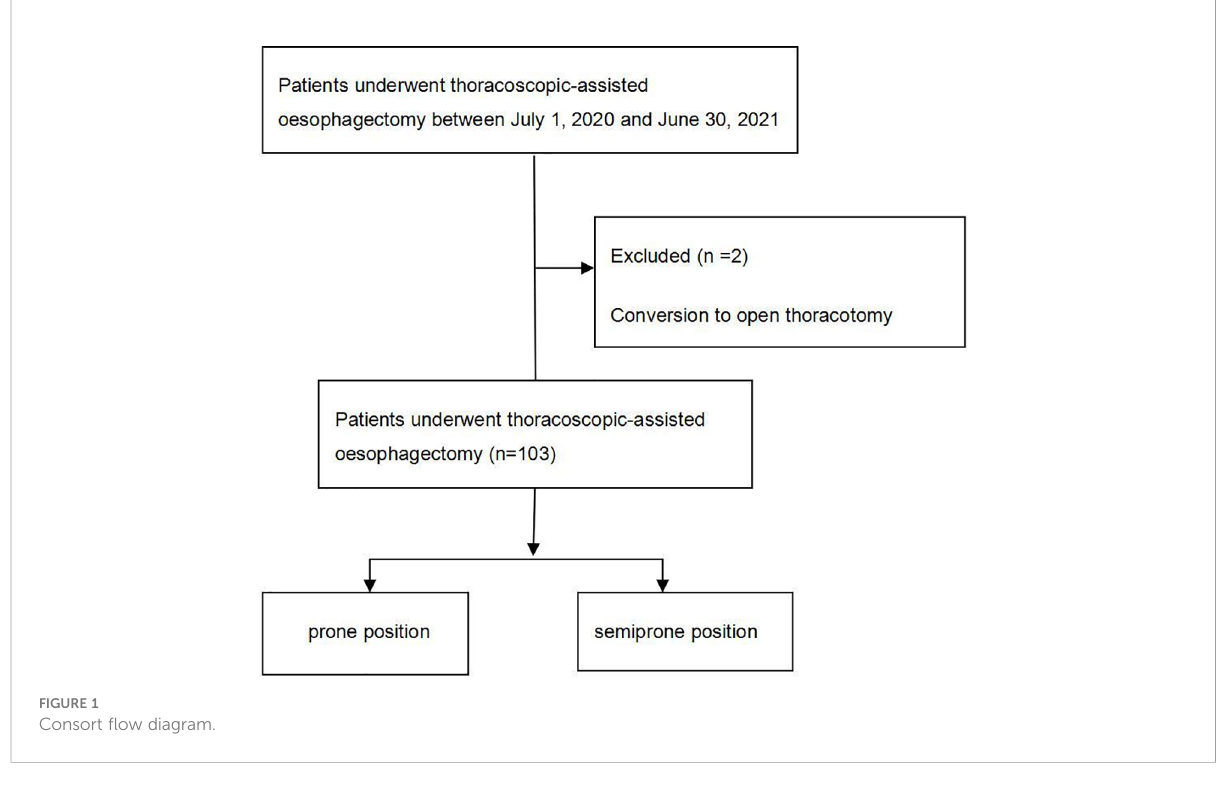
FIGURE 1 Consort fl ow